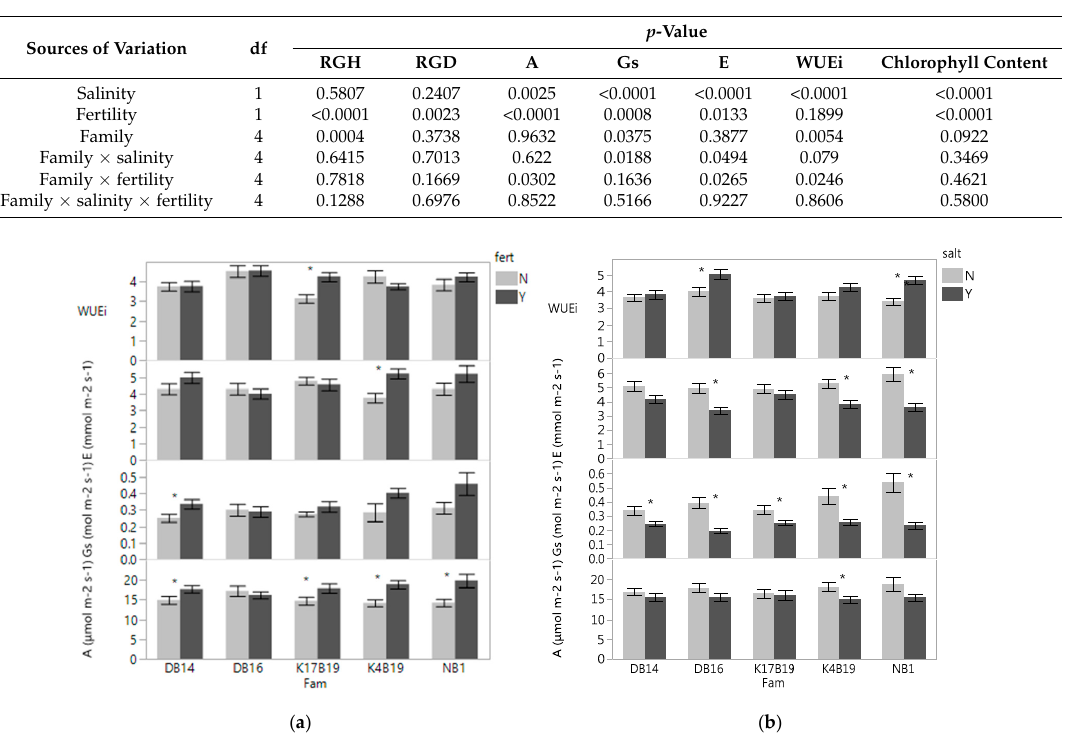
Figure 1. The effect of fertilizer ( a ) and salt ( b ) treatments on net photosynthetic rate (A), stomatal conductance (G s ), transpiration (E), and intrinsic water use efficiency (WUE i ) of Senegalia senegal families. Asterisk marks on bars mean significant effect of fertilizer ( a ) and salt ( b ) at p < 0.05.